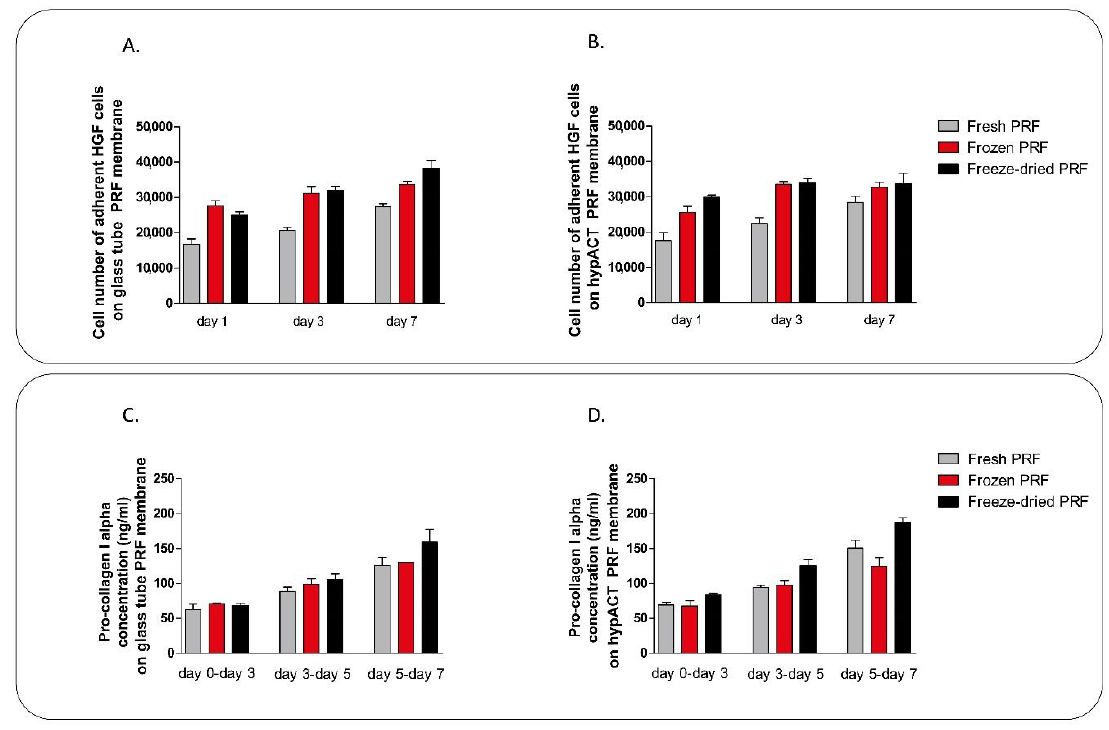
Figure 7. Adhesion and proliferation capacities of human gingival fibroblasts cultured on GT ( A ) and HI ( B ) PRF membranes. Pro-collagen I alpha secretion of the fibroblasts on GT ( C ) and HI ( D ) PRF during the culture period. Although a trend was observed, this does not reach the level of significance between fresh and frozen or freeze/dried samples.